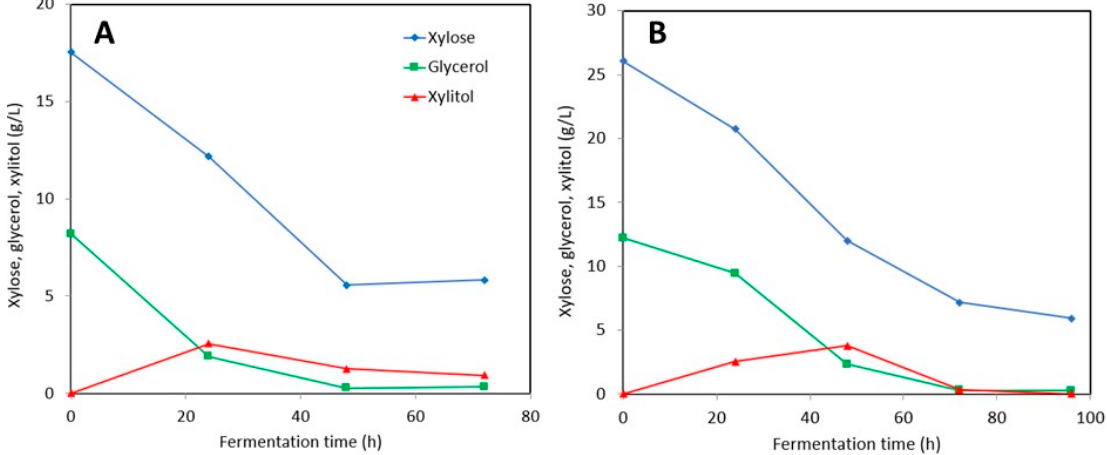
Figure 3. Concentration profiles of xylose ( ♦ ) and glycerol ( ■ ) consumption, and xylitol ( ▲ ) generation by C. mogii cultivated in ( A ) detoxified stillage media, and ( B ) stillage media that was detoxified and concentrated by 33%.